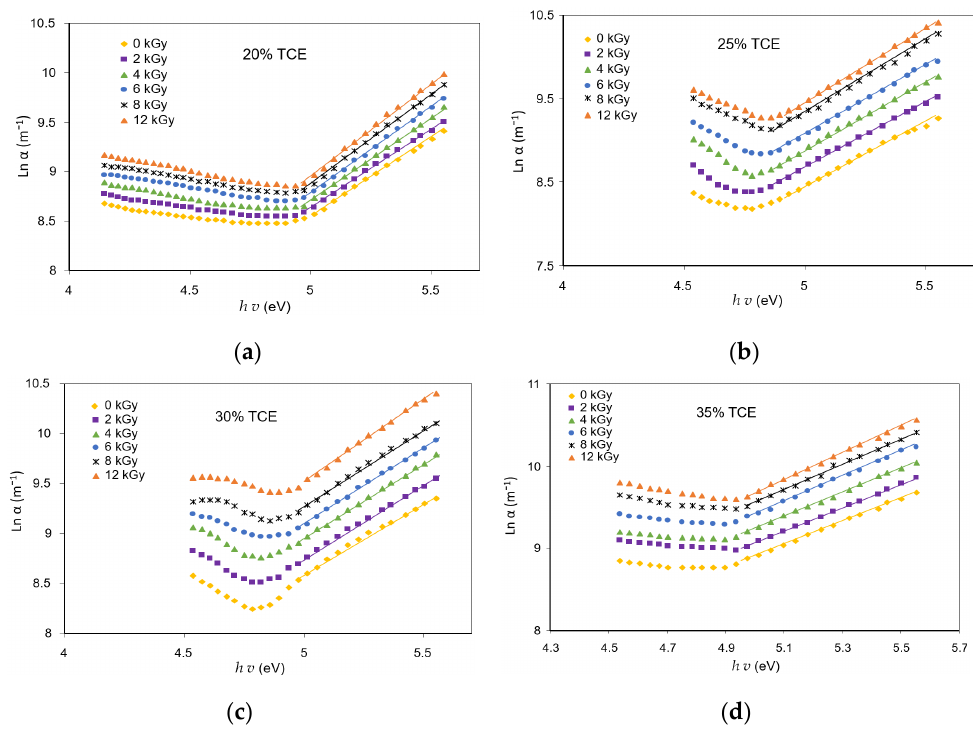
Figure 9. Variation of ln( α ) vs. h ν at various doses for; ( a ) 20%; ( b ) 25%; ( c ) 30%; and ( d ) 35% TCE composition of CR dyed PVA-TCE composites.